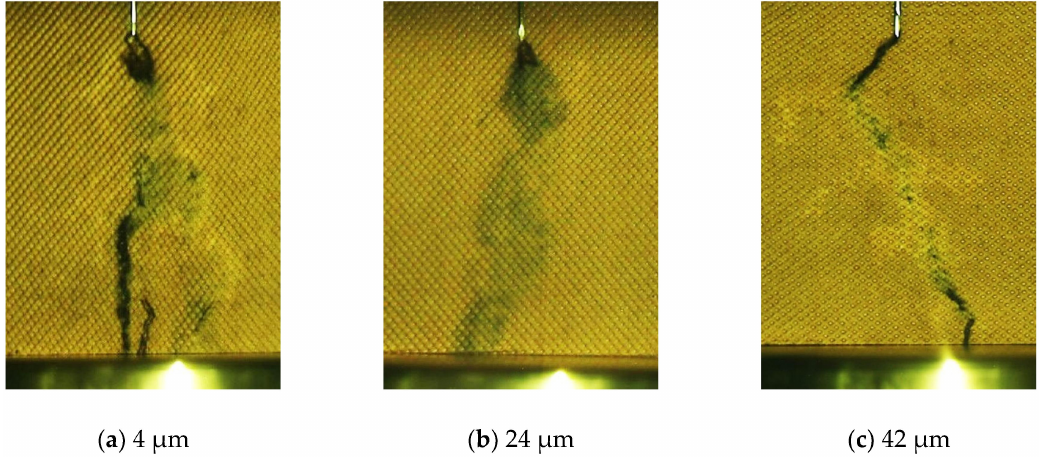
Figure 10. The trace of pressboard surfaces after tests under different